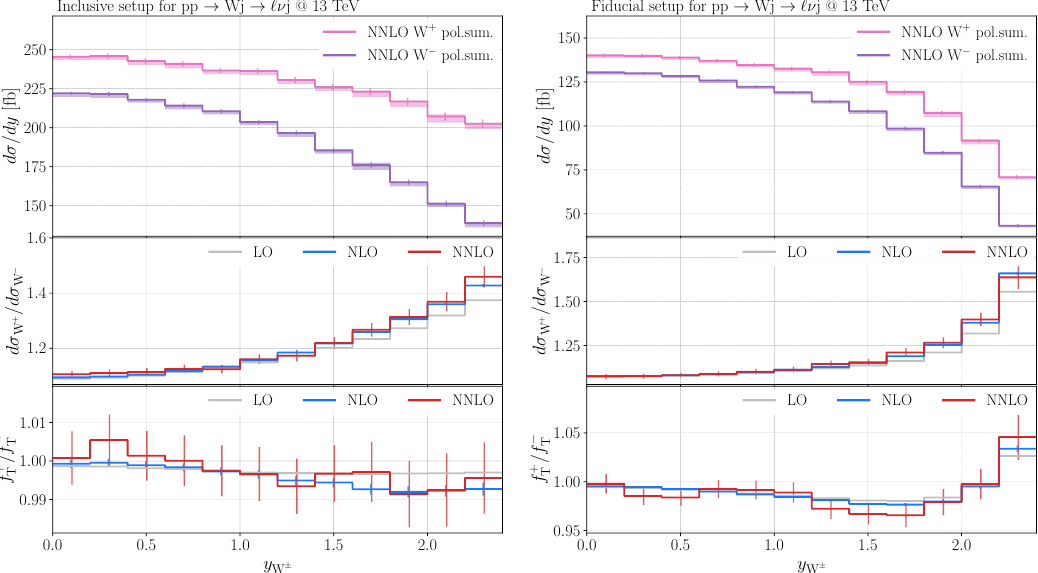
Figure 11 . Differential distributions of y W for pp → ‘ ± ( − ) ν ‘ j in the inclusive (left) and fiducial (right) setup. Same individual plot structure as in figure